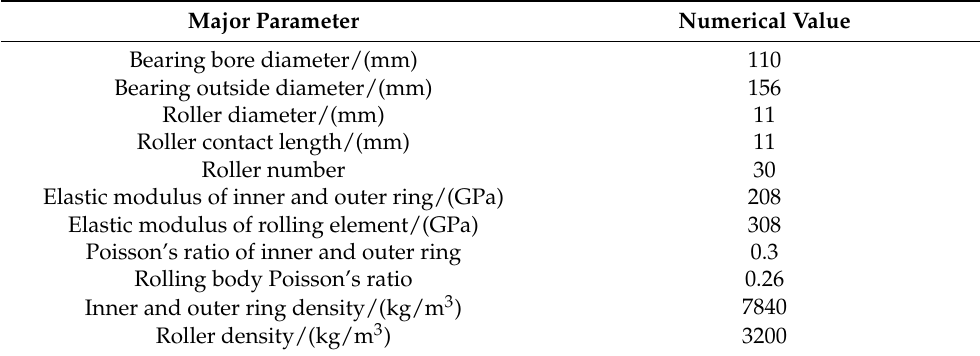
Table 1. Main parameters of cylindrical roller bearings.